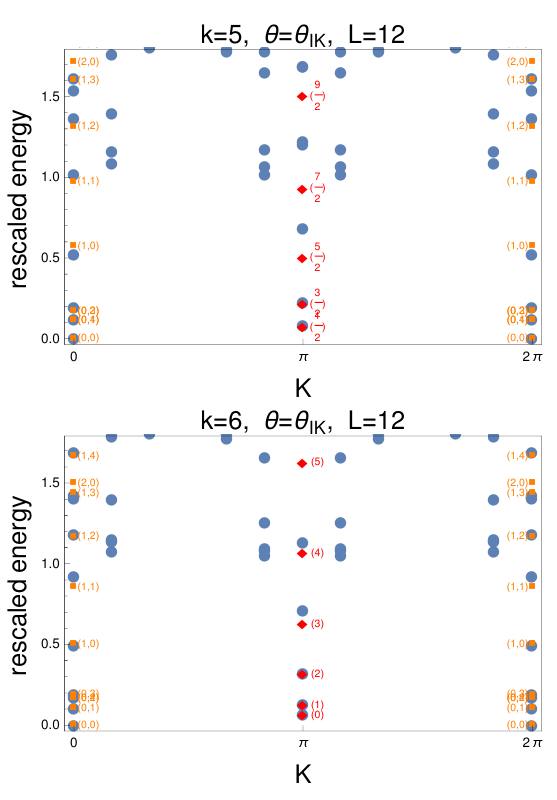
= θ , 2,1 IK π ( L − 1 ) π π , 4 ,..., 2 , and are displayed as blue L L L